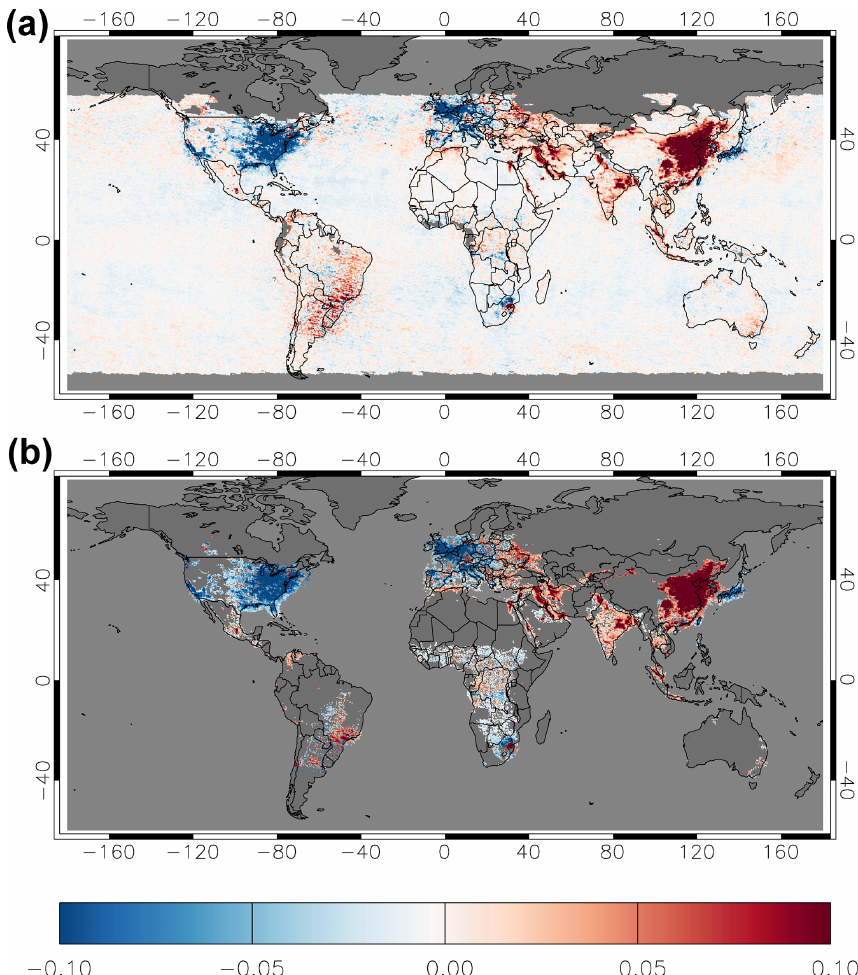
Figure 3. (a) Satellite-based trends of tropospheric NO 2 VCD (in 10 15 moleculescm − 2 yr − 1 ) for the period April 1996–September 2017. Only trends calculated for time series with at least 8 months per year are taken into consideration; (b) same as (a) but for statistically significant trends at the 95% confidence level and for grid cells with a long-term tropospheric NO 2 VCD mean of at least 1 × 10 15 molecules cm − 2